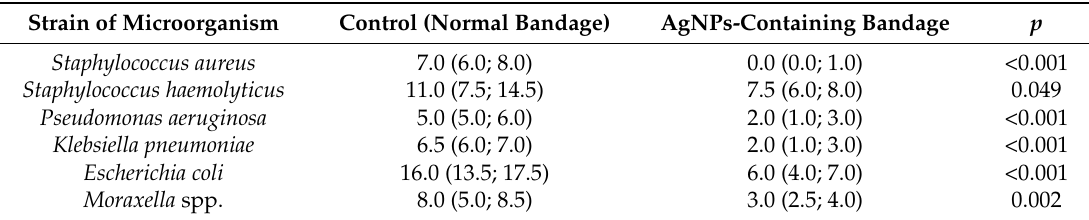
Table 3. The number of colony-forming units (CFU) of the studied microorganisms along the edge of the bandage at a distance to both sides of the edge equal to the diameter of one colony (Me (Q 1 ; Q 3 )) and the level of statistical significance ( p ) between control groups and gauze with AgNPs. Strain of